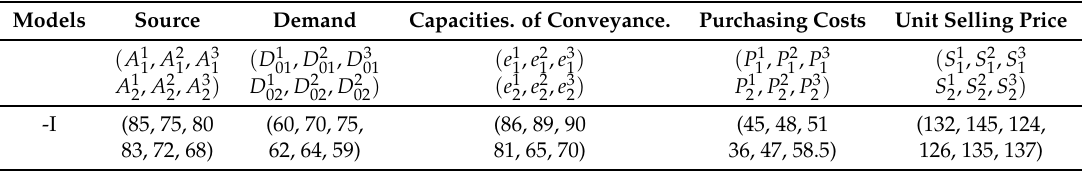
Table 16. Parametric values for the